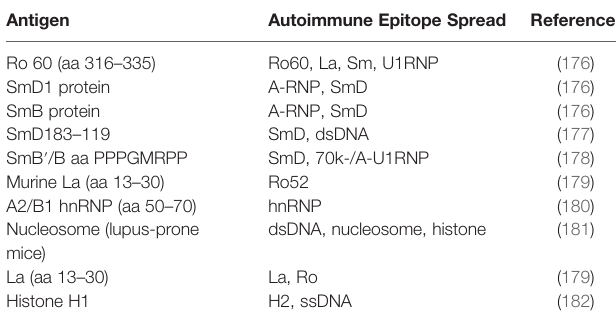
TABLE 2 | Epitope spreading in mouse models after autoantigen